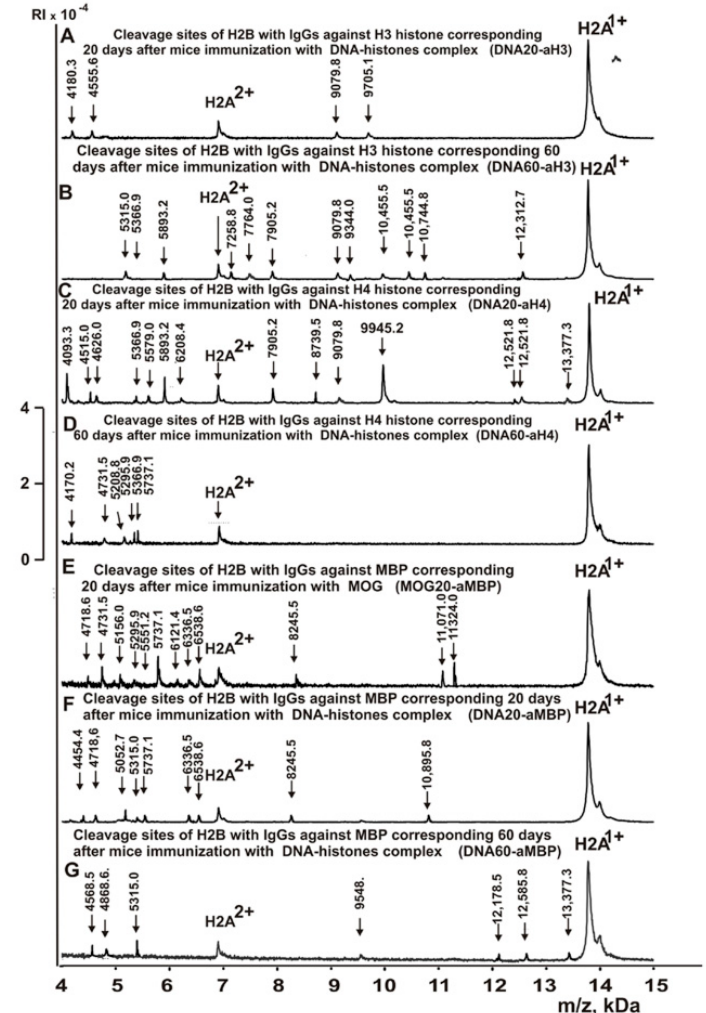
Figure 6. MALDI spectra of H2B (0.9 mg/mL) hydrolysis products with IgGs against two histones and MBP corresponding to 20 and 60 days after mouse immunization with DNA–histone complex: DNA20-aH3 ( A ), DNA60-aH3 ( B ), DNA20-aH4 ( C ), DNA60-aH4 (D), MOG20-aMBP ( E ), DNA20-aMBP ( F ), and DNA60-aMBP ( G ). All designations of IgG preparations and the values of m / z are shown in the